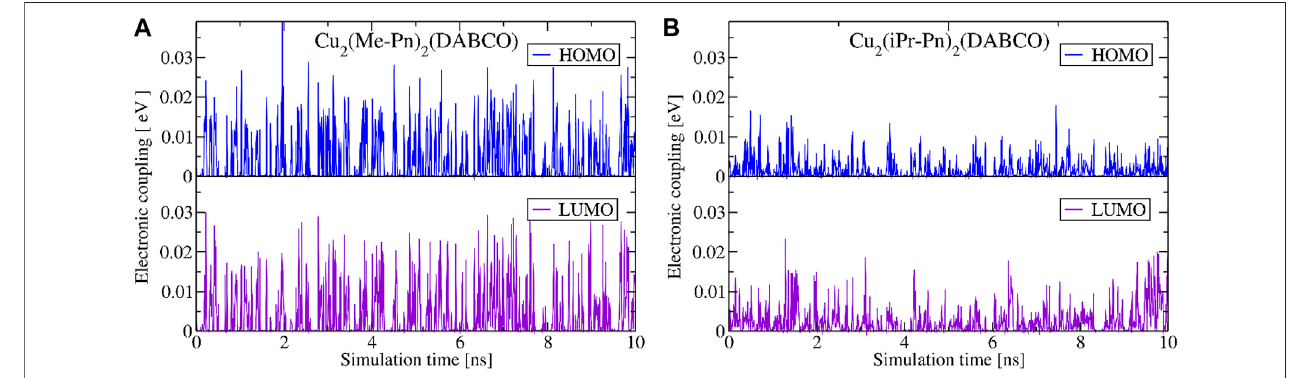
FIGURE 10| Absolute electronic coupling elements (B3LYP/def2-SVP) between HOMO (in blue) and LUMO (in purple) orbitals of functionalized ditopic pentacene linkers (Me-Pn and iPr-Pn, Figure 2 ) extracted from the force- fi eld MD simulations of Cu 2 (Me-Pn) 2 (DABCO) (A) and Cu 2 (iPr-Pn) 2 (pyz) (B) PCU-MOFs at 298 K.